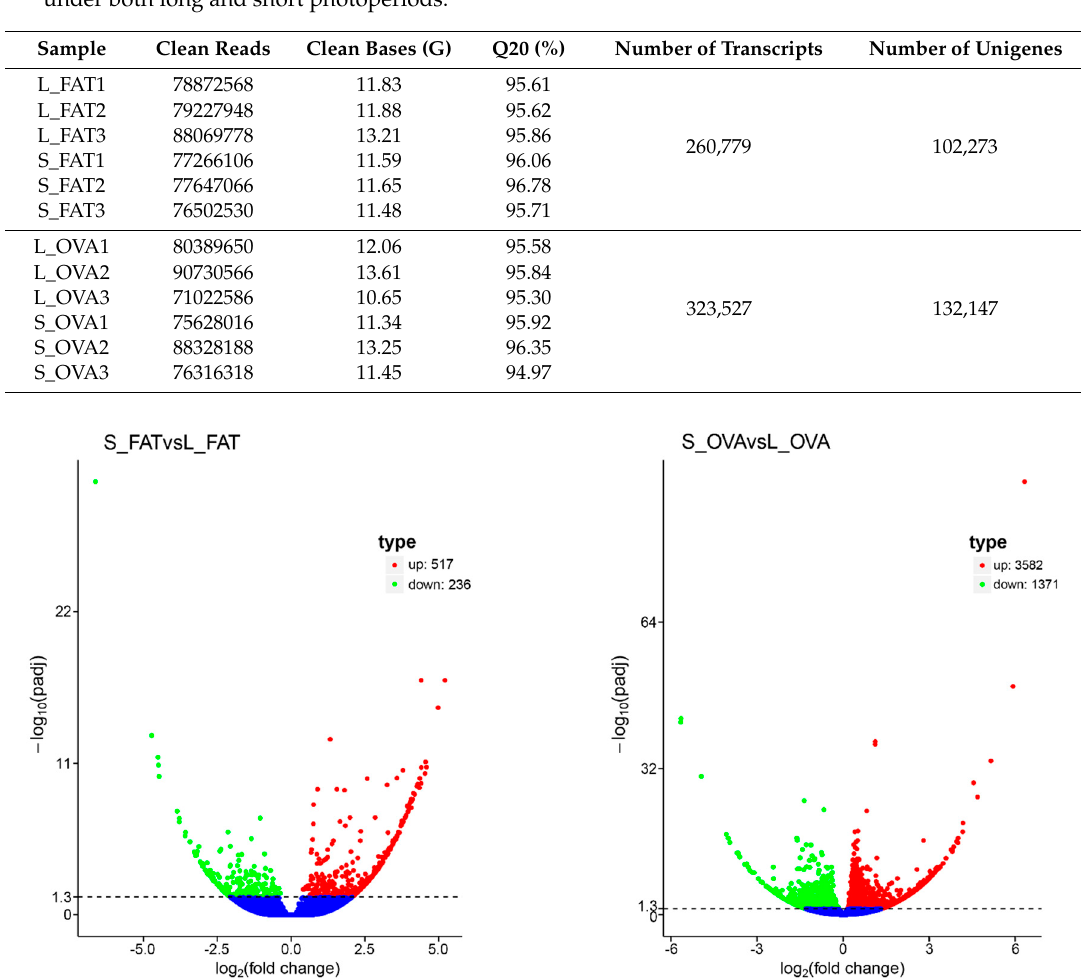
Figure 1. DEGs between long and short photoperiods treatments in L. migratoria fat body (left) and ovary (right) samples. DEGSeq (2010) R package (1.10.1) was used to carry out the differential expression analysis in digital gene expression and determining the expression via model based negative binomial distribution. Resulting p values were adjusted using the Benjamini and Hochberg’s approach for controlling the false discovery rate. Genes with an adjusted p -value of <0.05 explained by DEGSeq were assigned as differentially expressed. The x -axis represents the change of gene expression in different groups; whereas the Y-axis represents the statistical significance of gene expression change. − log10(padj) means − log10 (adjusted p -value). The smaller the adjusted p -value in − log10(padj), the greater the difference will be (significant). Blue dots in the figure represent the genes with no significant difference; red dots represent the up-regulated genes with significant difference, whereas green dots represent the down-regulated genes with significant difference.